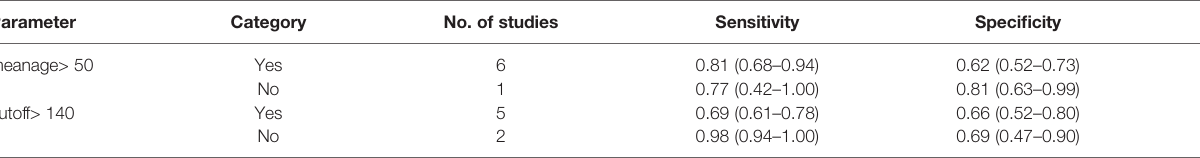
TABLE 4 | meta-regression of preoperative HE4.